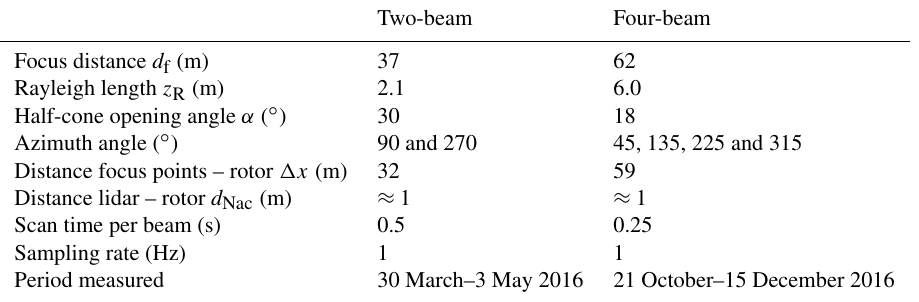
(cid:16) α(cid:15) 2 / 3 , L U 2